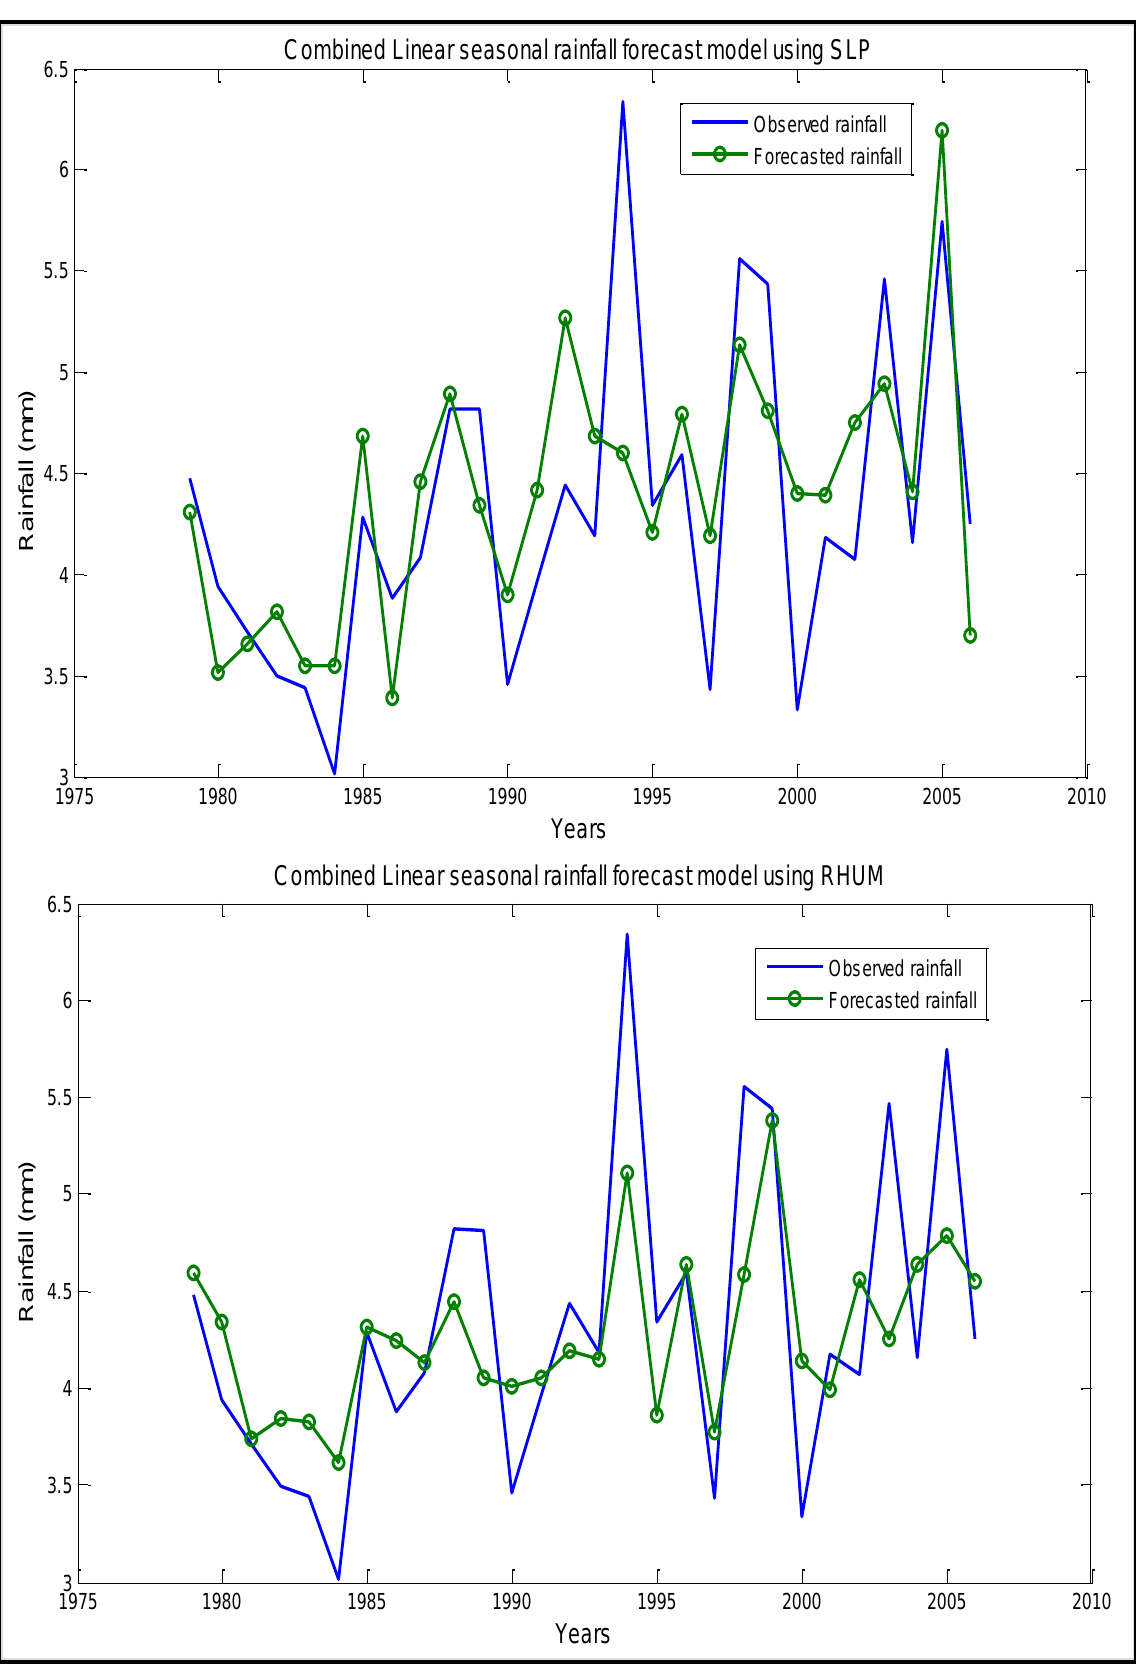
Figure 6. Combined linear model for seasonal rainfall forecast using SLP (upper panel) and RHUM (lower